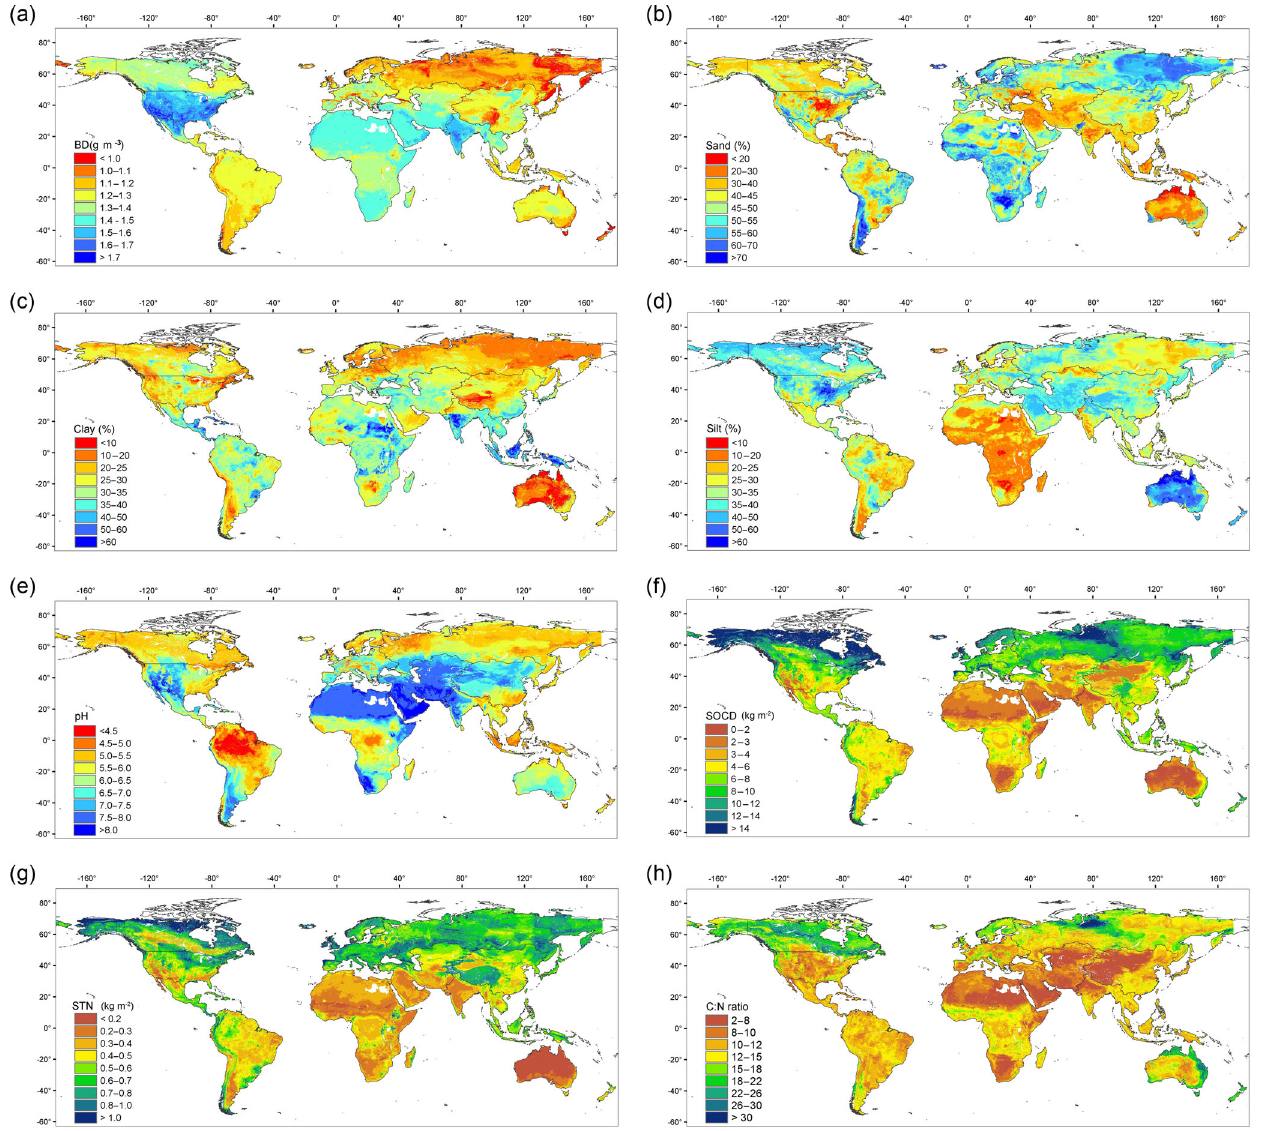
Figure 2. Maps of surface (0–30cm) soil properties. (a) BD (bulk density, gm − 3 ), (b) sand fraction (%), (c) silt fraction (%), (d) clay fraction (%), (e) pH, (f) SOCD (soil organic carbon density, kgm − 2 ), (g) STND (soil total nitrogen density, kgm − 2 ) and (h) C : N